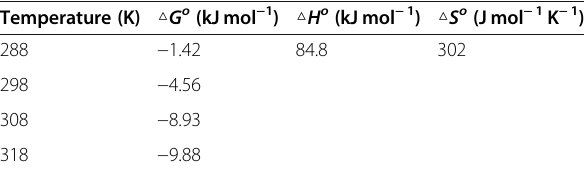
Table 6 Thermodynamic model parameter values at different temperatures with